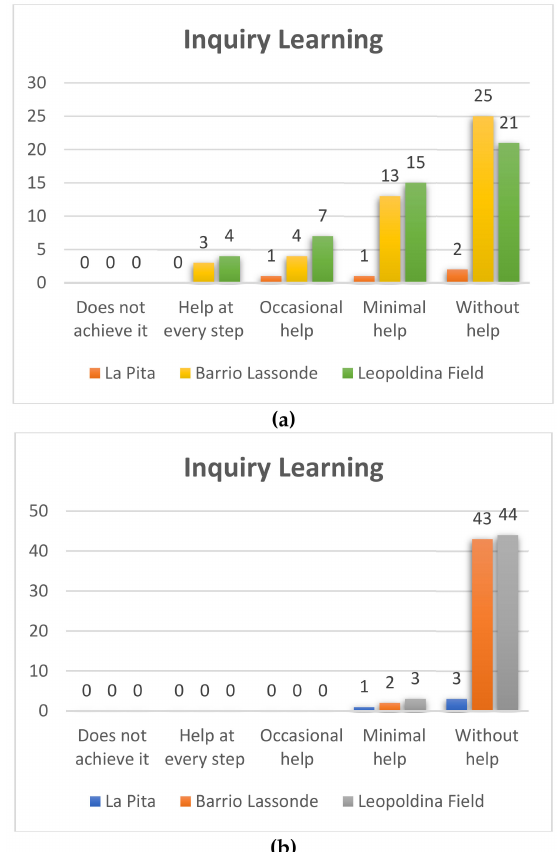
Figure 11. Kindergarden inquiry learning Pre-Test ( a ) and Post-Test ( b